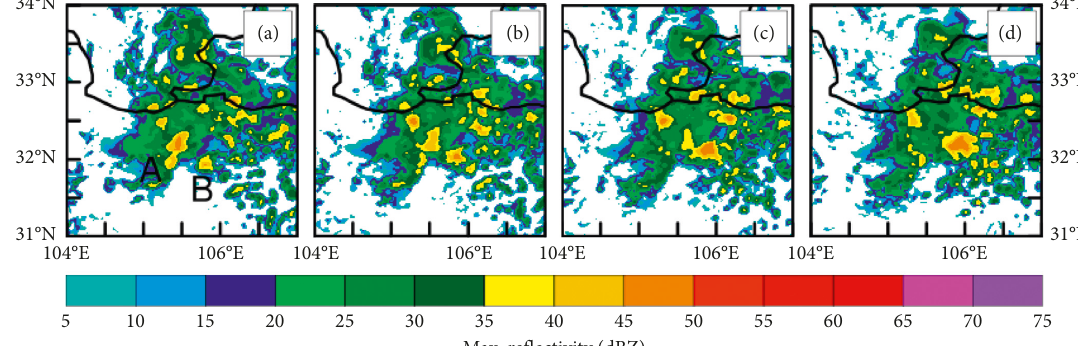
Figure 11: Maximum radar reflectivity for merging of precipitation clouds A and B on June 27: (a, e) 21:00 UTC; (b, f) 21:30 UTC; (c, g) 22:00 UTC; (d, h) 22:30 UTC (unit: